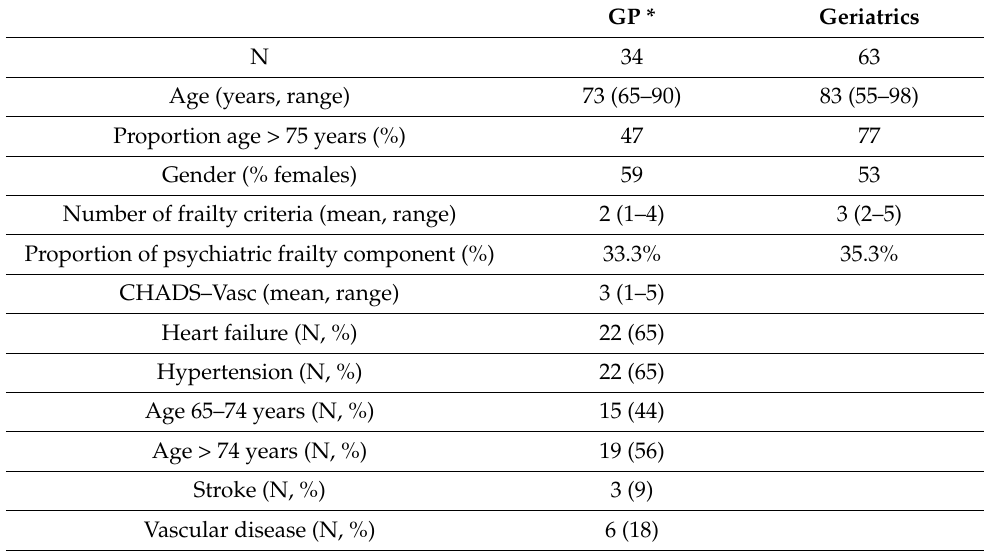
Table 3. Patient characteristics for patients who underwent C3 Holter monitoring.